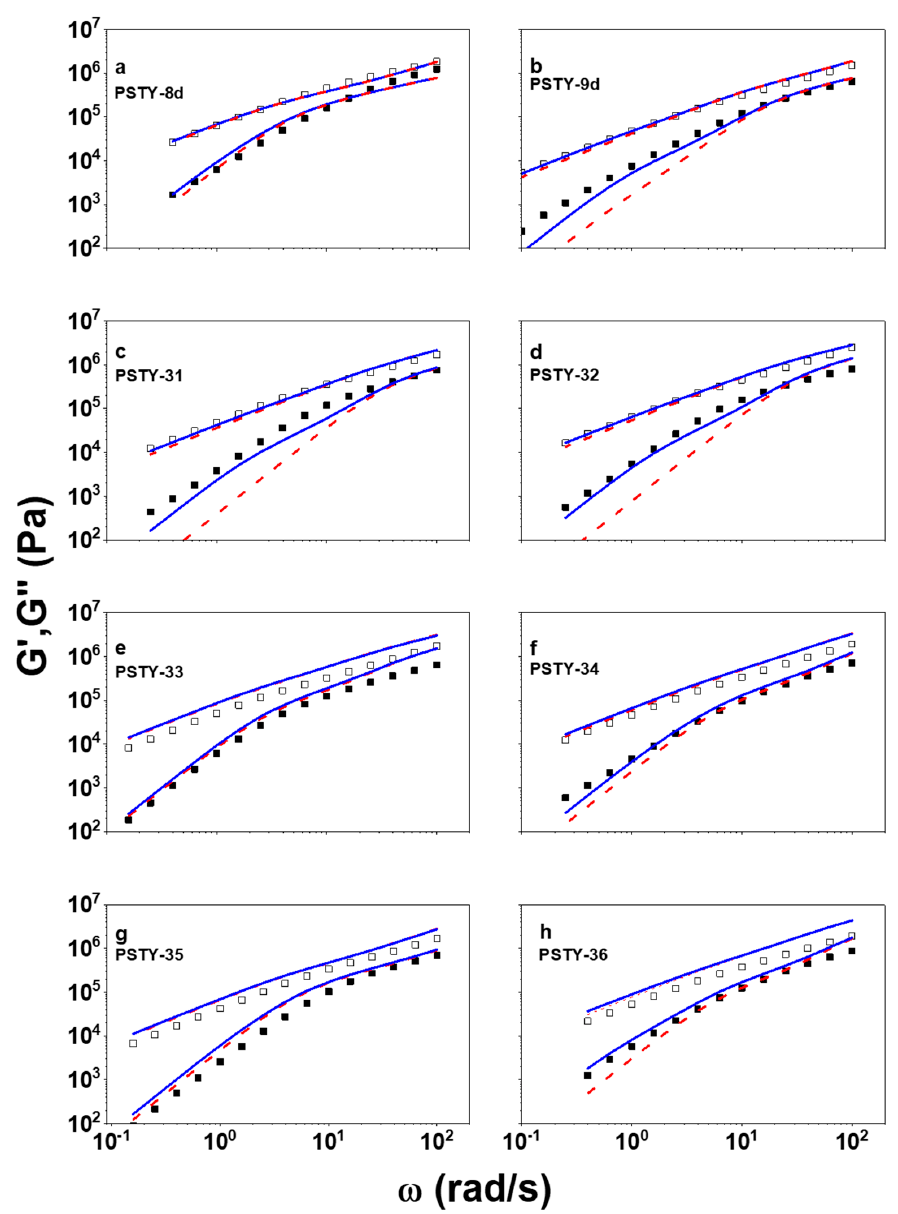
Figure 1. Storage and loss moduli, G ′ ( ■ ) and G ″ ( □ ), respectively, as functions of oscillatory frequency ω for the investigated multicyclic polystyrenes at a reference temperature of 403 K. The blue solid and red dashed curves are model predictions of Equation (6) with and without the contribution of linear contaminants, respectively (see text).